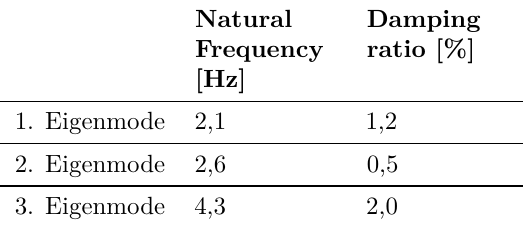
Figure 3. Experimentally Investigated 7-story RC- building. [6]